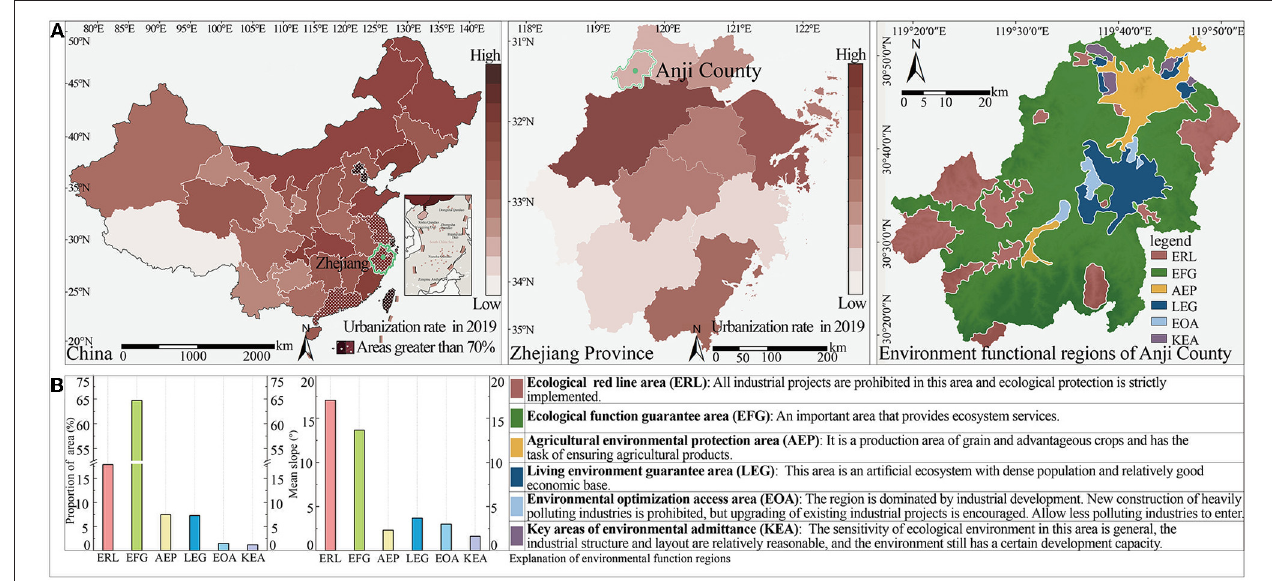
FIGURE 1 | Location and basic information of the study area. (A) Is the location and environmental function regions of Anji County and (B) is the basic information and legend explanation of each environmental functional region.